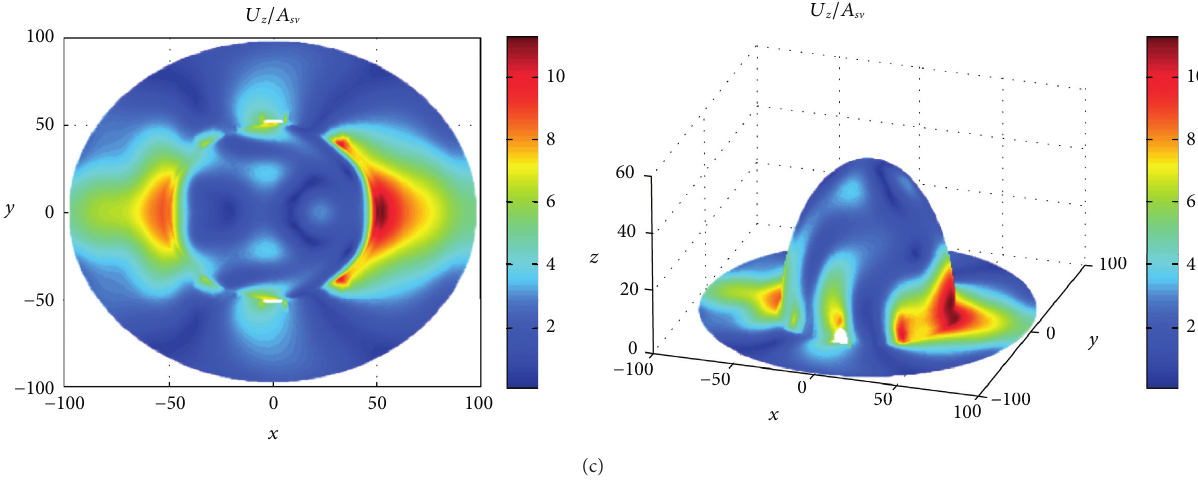
Figure 17: Surface displacement amplitude of the 3D tunnel mountain under the incident SV wave ( η � 2 . 0 , α � 30 ° ): (a) surface dis- placement amplitude in x direction; (b) surface displacement amplitude in y direction; (c) surface displacement amplitude in z